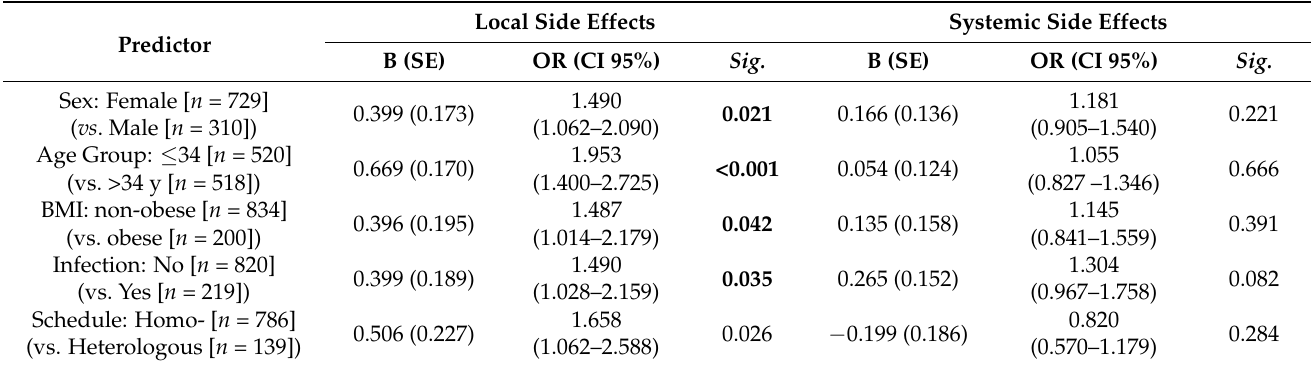
Table 4. Risk Factors of COVID-19 Vaccines Side Effects Experienced by Saudi Healthcare Workers Responding to CoVaST-SA, ( n =